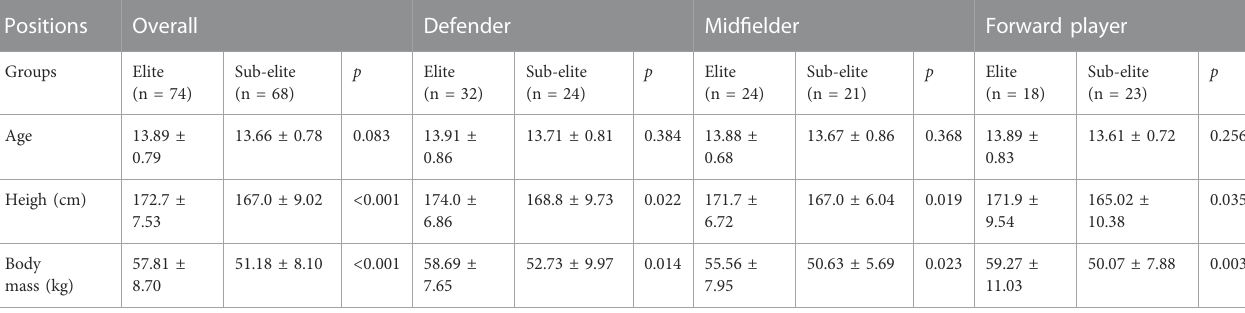
TABLE 1 Anthropometric characteristics of all subjects in different positions. Positions Overall Defender Mid fi elder Forward player Groups